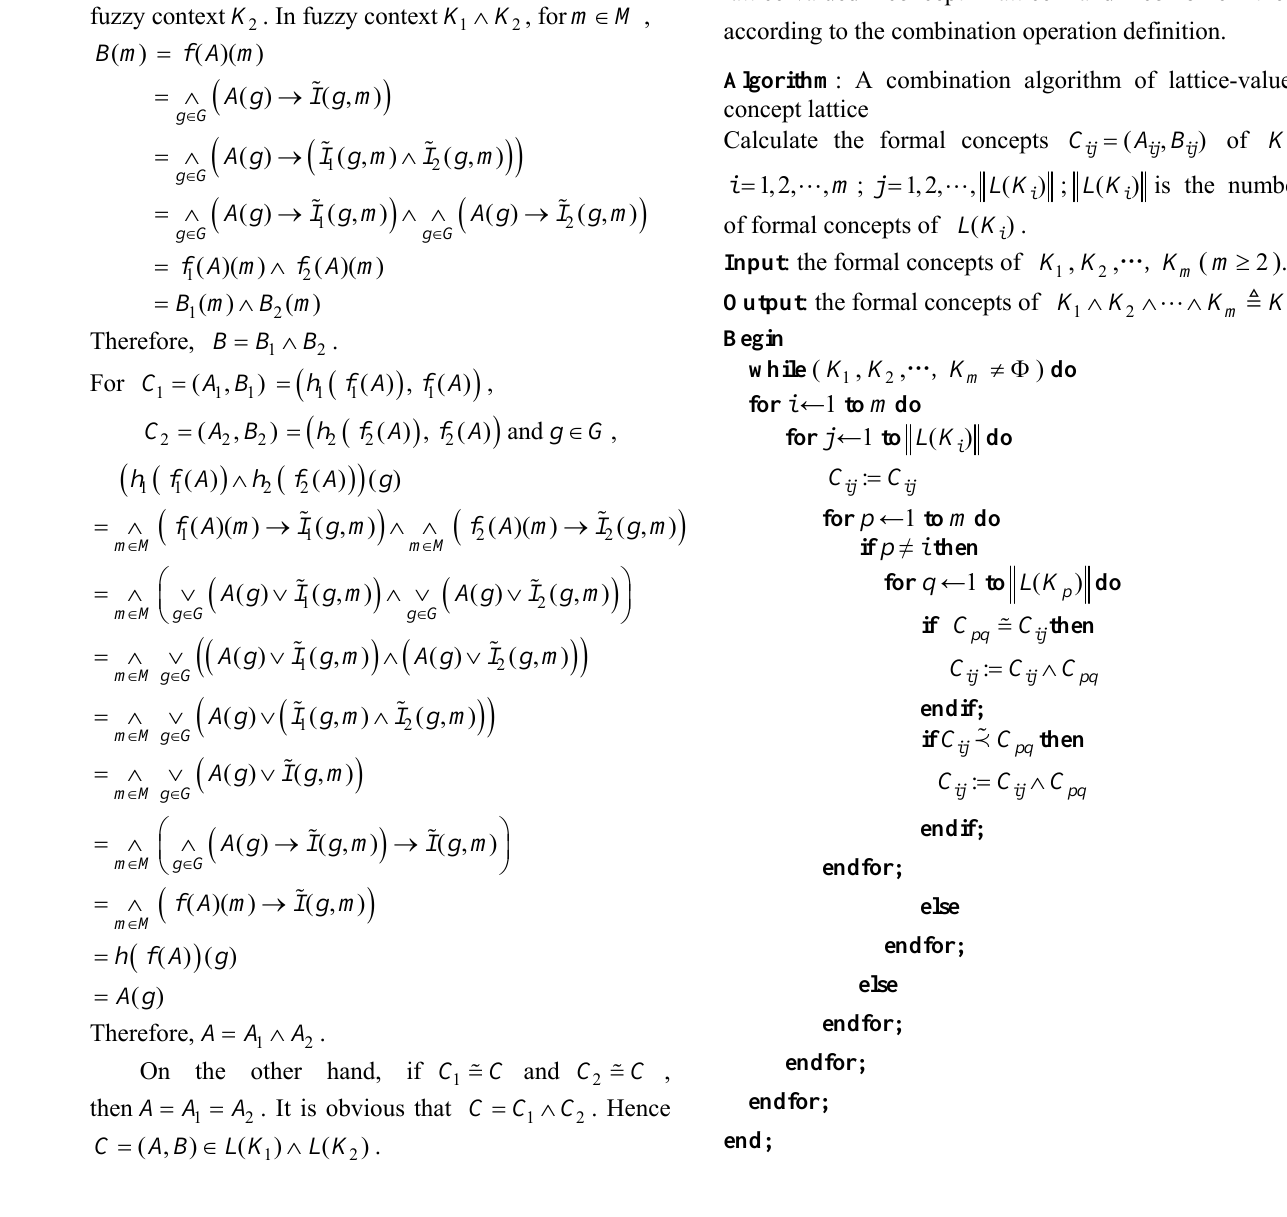
Algorithm : A combination algorithm of lattice-valued concept